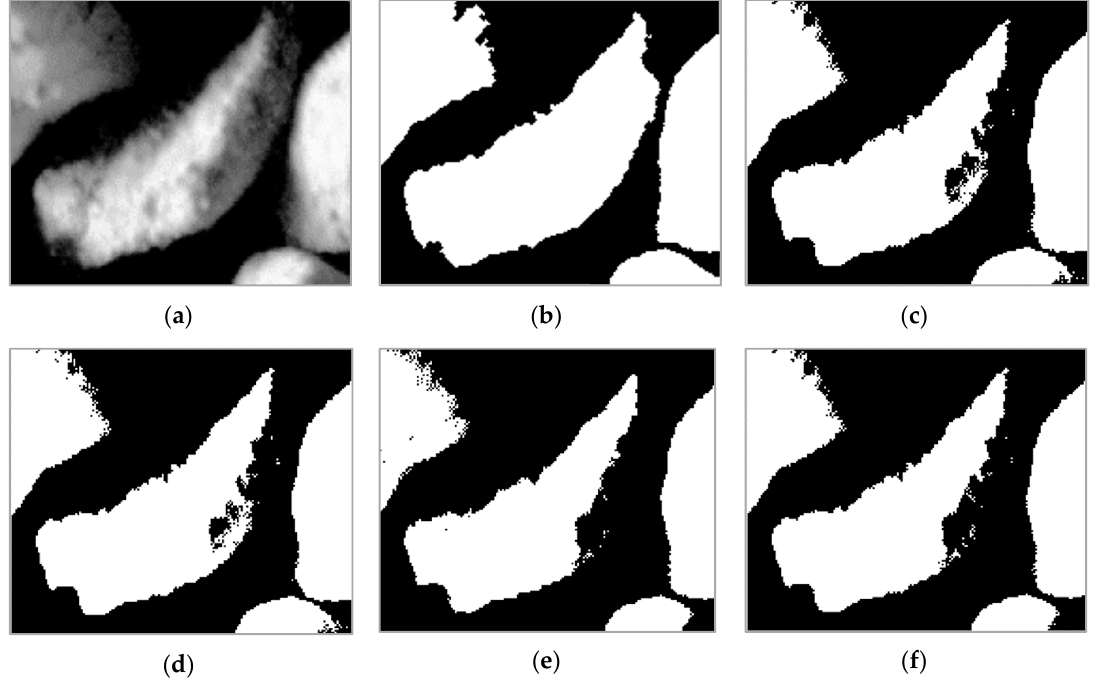
Figure 13. The original zoomed sample image ( a ), proposed method ( b ), global clustering ( c ), global inter-class variance ( d ), local Niblack ( e ), local Sauvola ( f ).